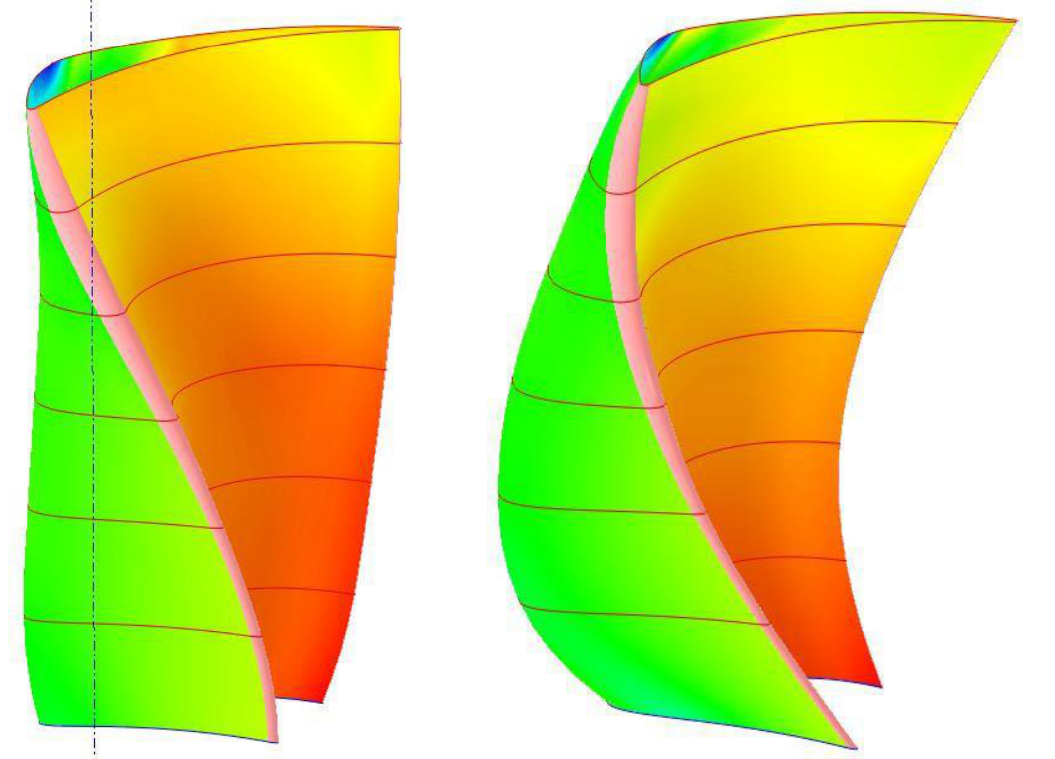
Figure 9. Comparison between a standard radial blade (left) and a high-performance bow-type one (right).